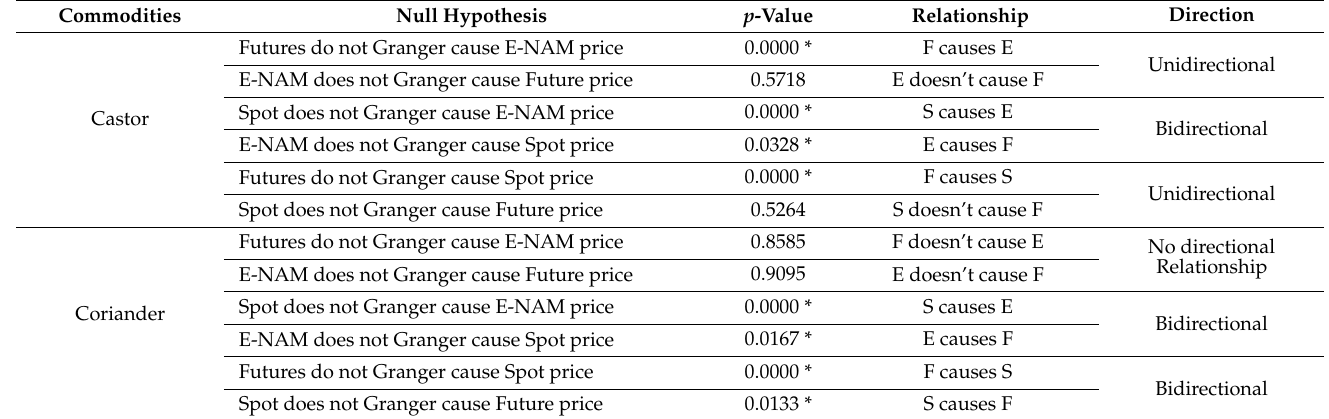
Table 4. Results of Granger Causality